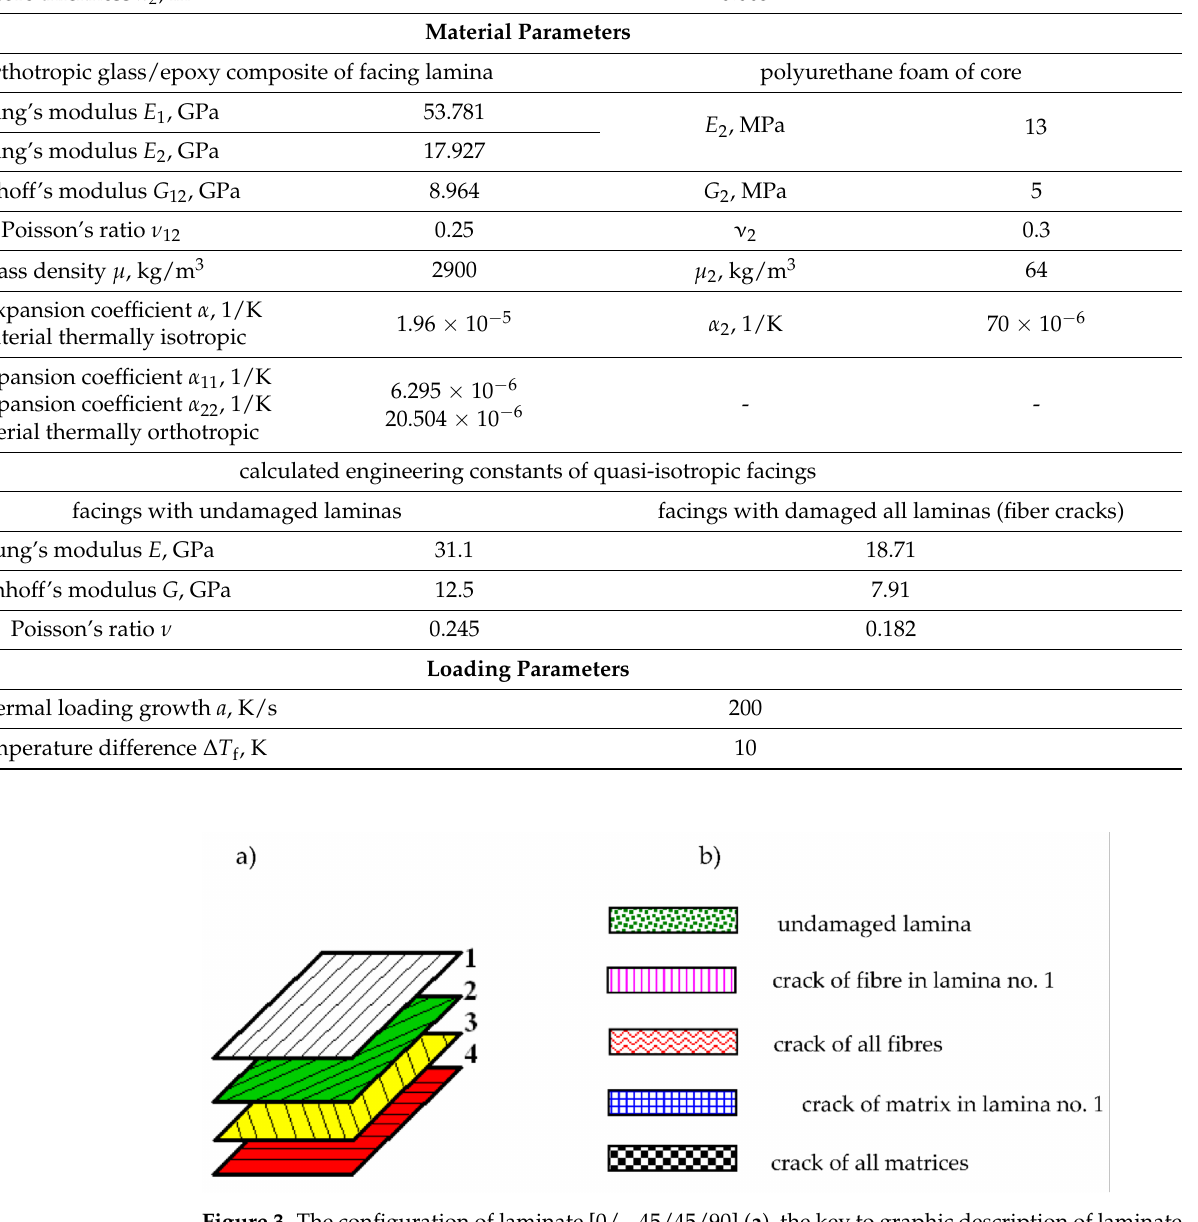
Figure 3. The configuration of laminate [0/ − 45/45/90] ( a ), the key to graphic description of laminate failure ( b